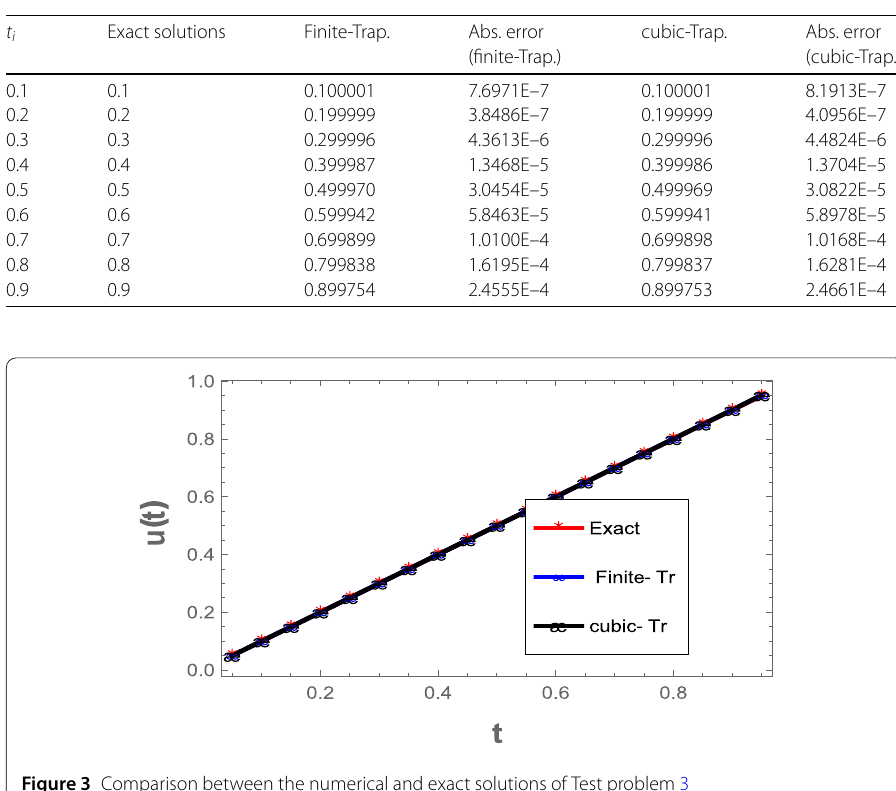
Table 3 The exact and numerical solutions of Test problem 3